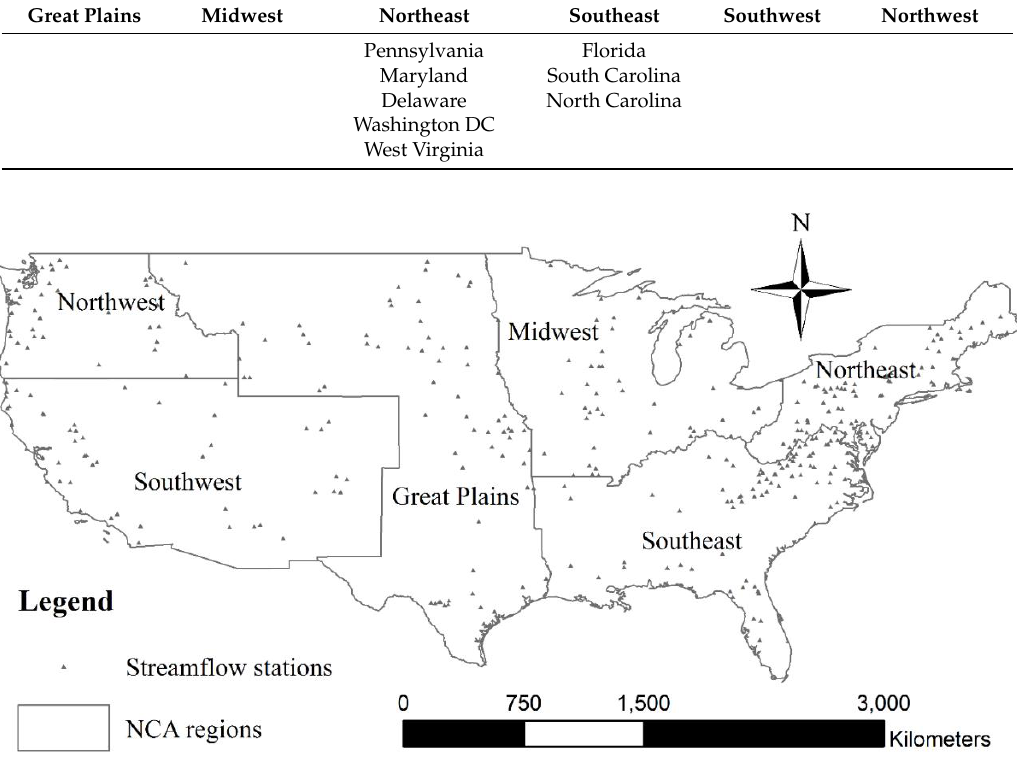
Figure 1. Map showing NCA regions and streamflow stations.